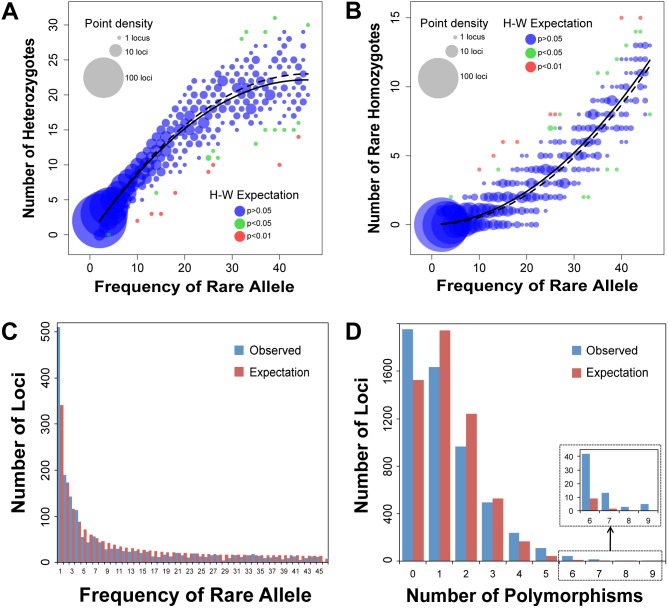
Comparison of indigobird ddRAD results to population genetic expectations.(A) Number of heterozygotes and (B) number of homozygotes for the rare allele versus rare allele frequency for 1,721 loci with a single bi-allelic SNP. The area of data points is proportional to the number of individual genotypes at each coordinate; observed relationship (sold lines), expected (dotted lines). Loci deviating from Hardy-Weinberg expectations are highlighted in green and red. (C) Comparison of the empirical allele frequency distribution for the same 1,721 loci with neutral expectations for a population of constant size. (D) Distribution of polymorphisms among full-length (97 bp) loci genotyped in all 46 samples in RAD10 compared to a Poisson distribution, which assumes equal evolutionary rates across loci.